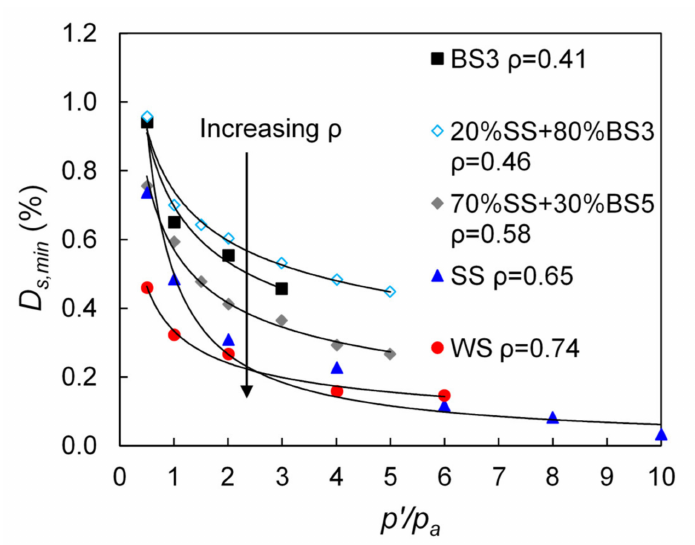
Figure 6. Variation of small-strain damping ratio with normalized confining pressure for five tested sands with different particle